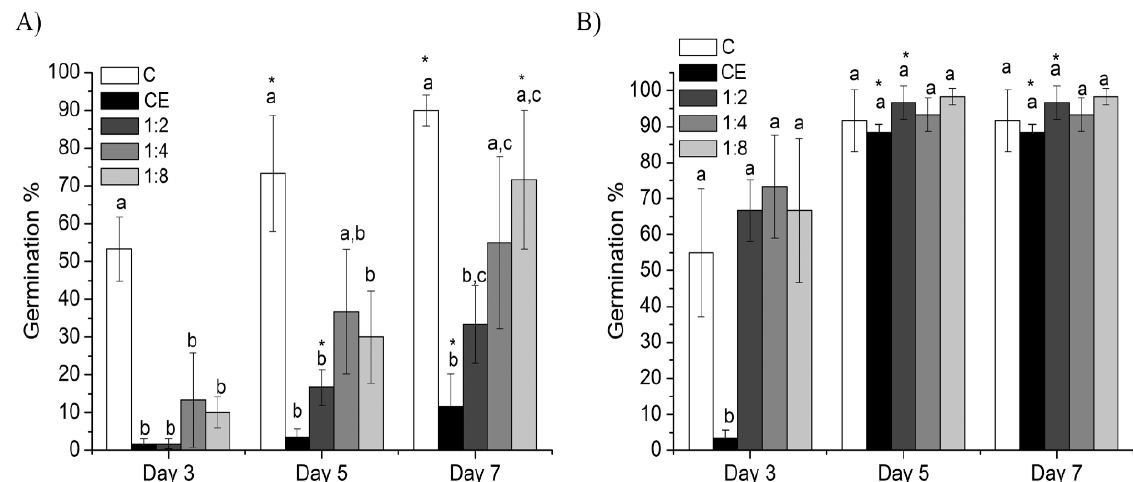
Figure 2. Germination % of wheat (A) and pea (B) seeds treated with different concentrations of walnut leaf aqueous extract . Different lowercase letters a, b, c indicate a statistically significant difference between treatments in the same period, while the symbol * indicates a statistically significant difference in the same treatment that occurred over time (day 5 or 7) compared to day 3 (p